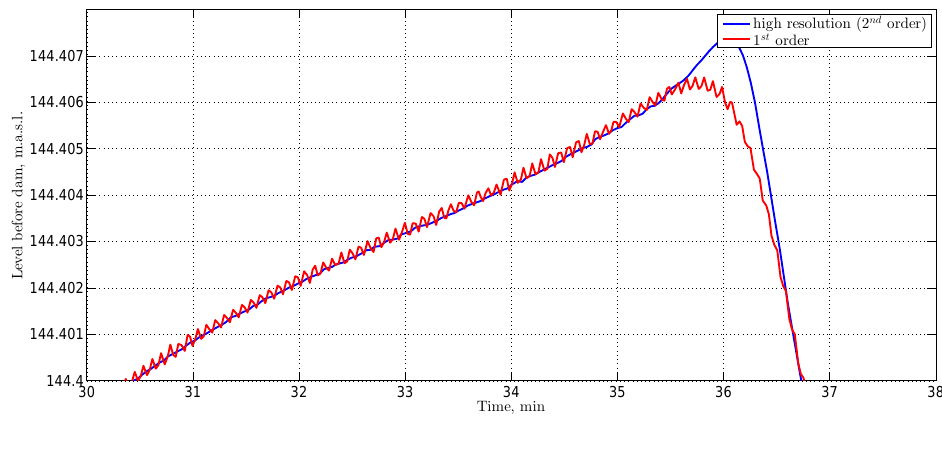
Figure 5: Zoomed plot of the water level ahead of the Grønvollfoss dam (ode23